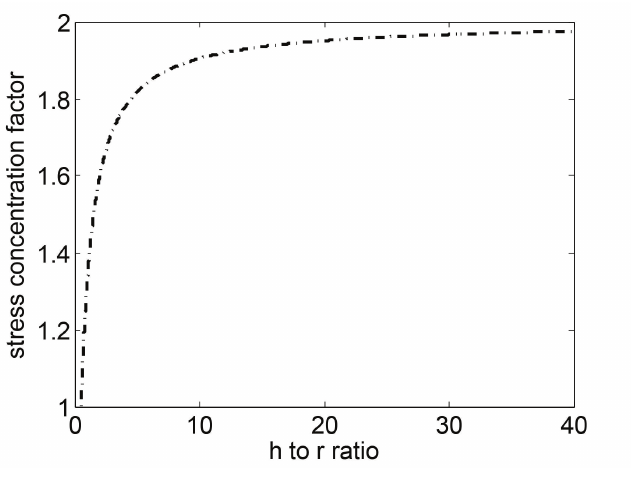
Figure 16. Stress Concentration Factor vs. η = h